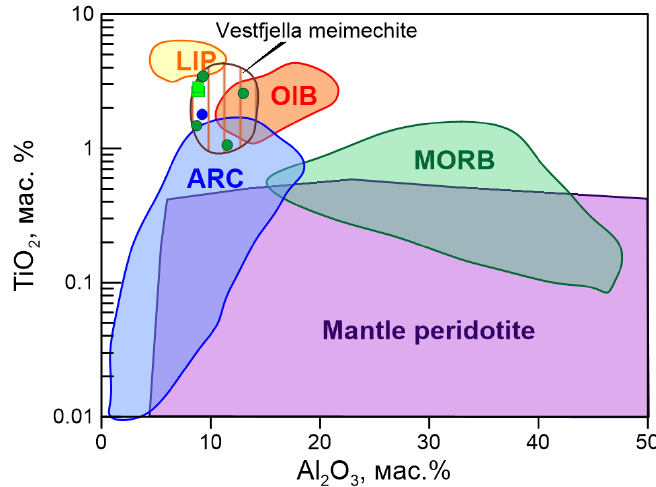
Figure 9. Al 2 O 3 vs. TiO 2 for primary Cr-spinels of the Ulan-Khan and Onguren intrusions. Fields LIP, OIB, ARC, MORB, mantle peridotite after [6], and Vestfjella meimechites after [45]. LIP: large igneous provinces; OIB: oceanic island basalts; ARC: island arcs; MORB: mid-ocean ridge basalts.